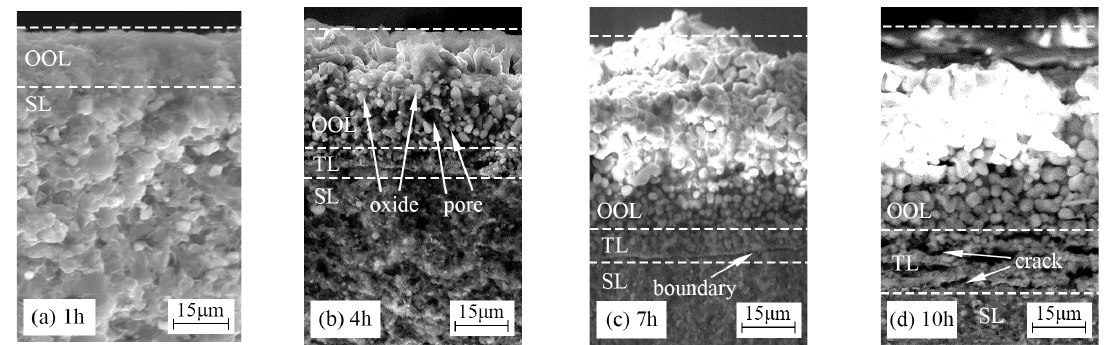
Figure 7. Fracture morphologies of TBHB at 1100 ◦ C in different oxidation times: ( a ) 1 h, ( b ) 4 h, ( c ) 7 h, ( d ) 10 h.